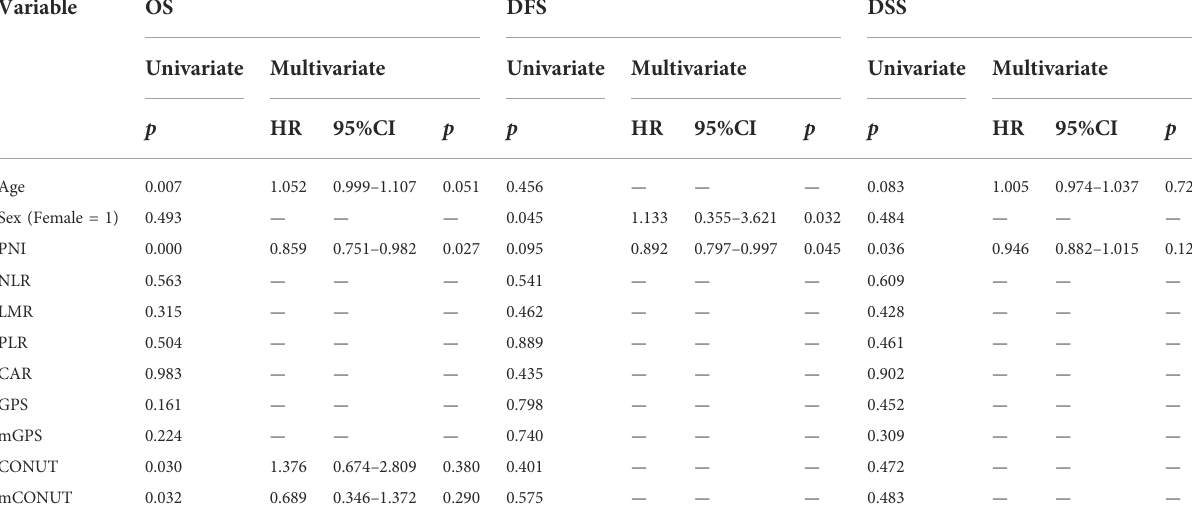
TABLE 2 Univariate and multivariate Cox proportional hazards assessments for prognosis in patients with OSCC.